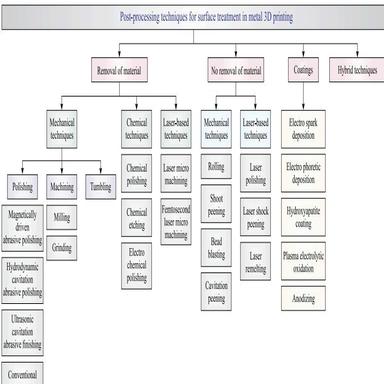
A classification of post-processing techniques for surface treatment of 3D-printed metal parts.